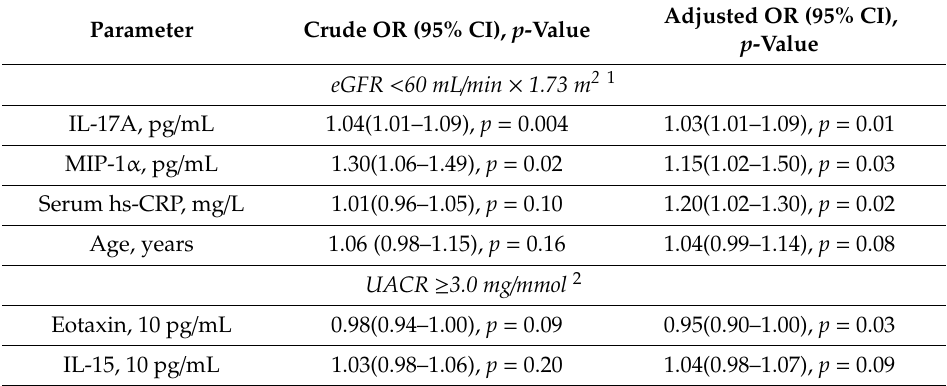
Table 3. Predictors for declined eGFR and elevated UACR in T2D patients Parameter Crude OR (95% CI), p